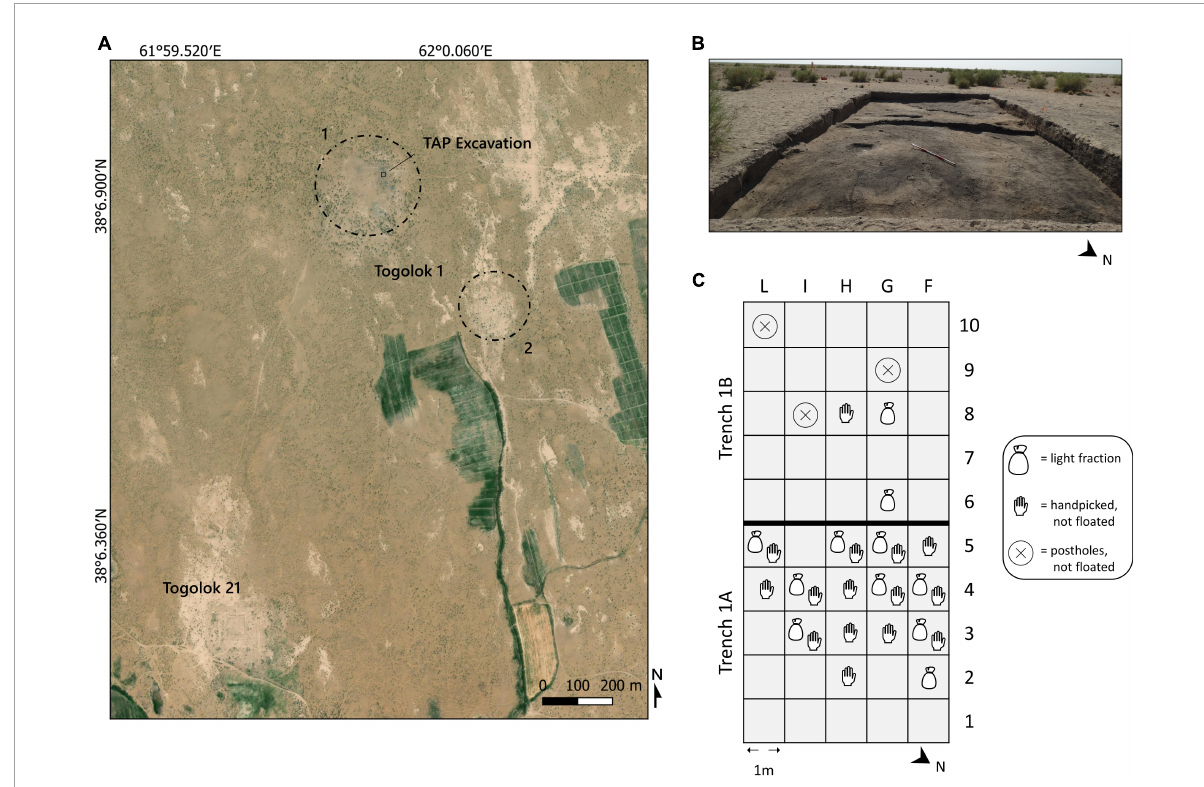
FIGURE2 (A) Map of Togolok 1 showing: (1) Tepe 1, (2) Tepe 2, and the location of TAP’s excavation units. Map created with QGIS using World Imagery Basemap, Sources: Esri, DigitalGlobe, GeoEye, i-cubed, USDA FSA, USGS, AEX, Getmapping, Aerogrid, IGN, IGP, swisstopo, and the GIS User Community. (B) Overview of Trenches 1A and 1B, photo courtesy of TAP. (C) Grid overlay of Trenches 1A and 1B showing the squares where archaeobotanical samples were